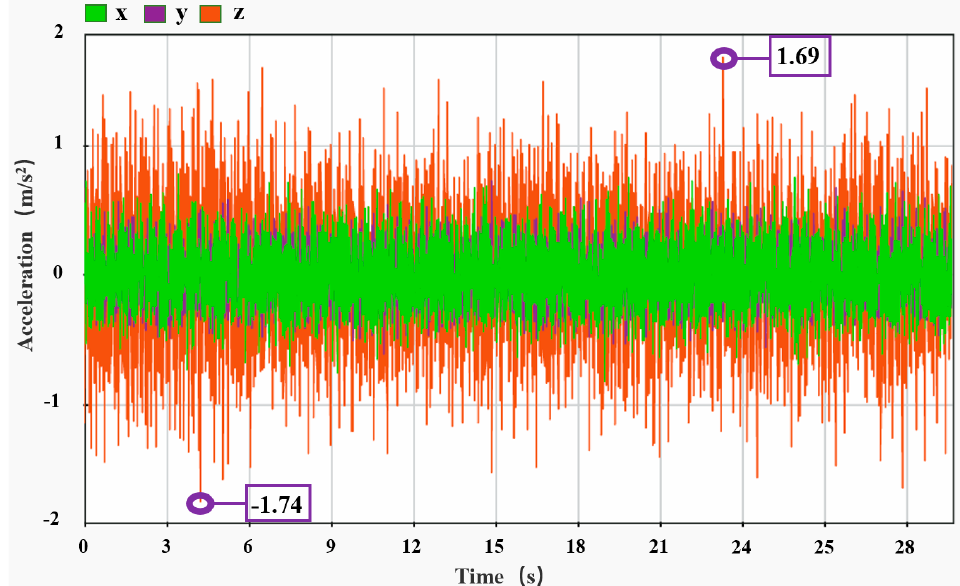
Figure 11. Test results of the static no-load strut. Figure 11. Results of static no-load test of support rod.